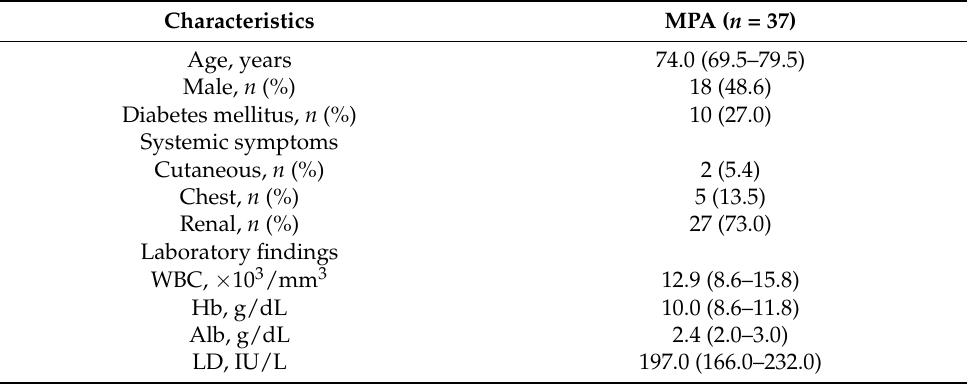
Table 1. Clinical characteristics of patients with